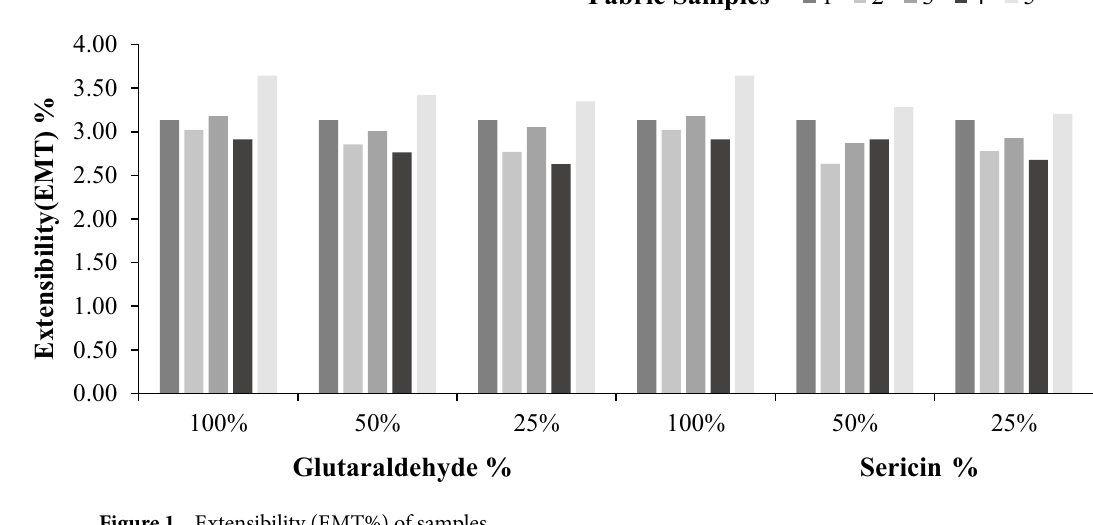
Figure 1. Extensibility (EMT%) of samples.